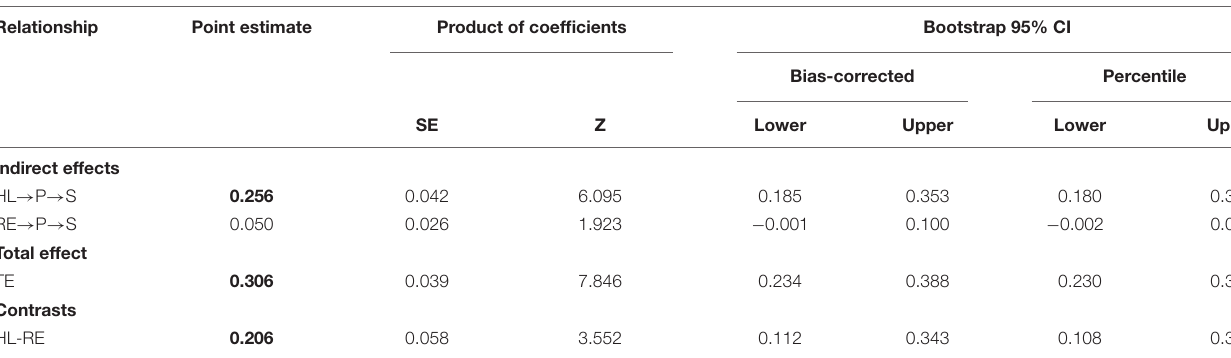
TABLE 6 | Intermediary effects between factors in the